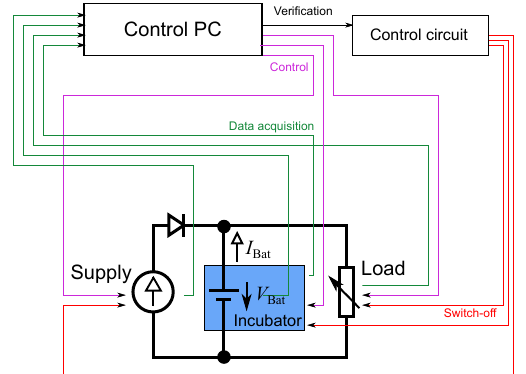
Figure 4. Experimental